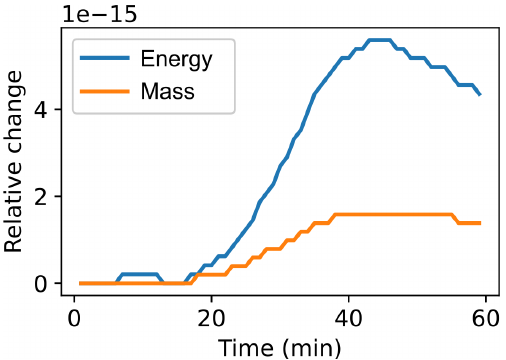
Figure 14. Time evolution of the mass and total energy loss (relative change when compared against initial conditions) for a moist ther- mal bubble simulation. Blue line: relative change in energy; orange line: relative change in